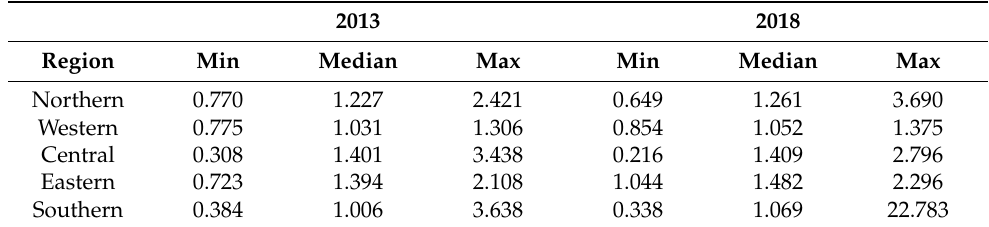
Table 2. Summary of housing affordability in Auckland.